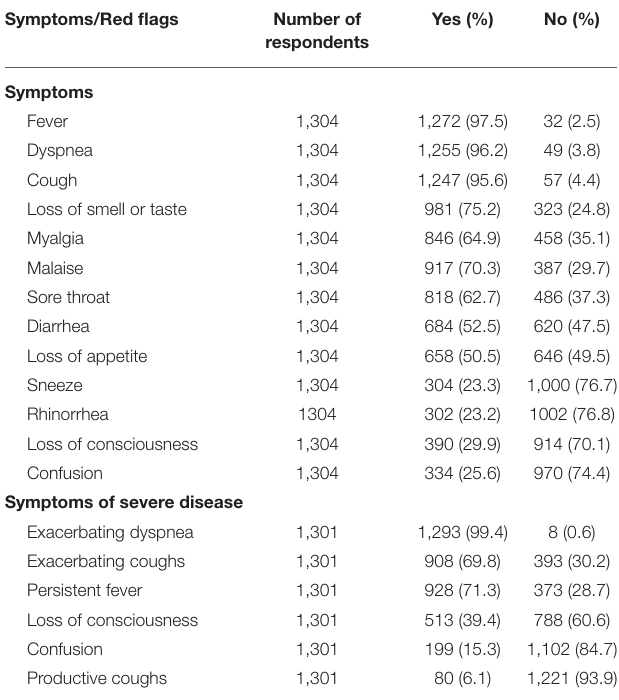
TABLE 1 | Sociodemographic characteristics of participants. Variable